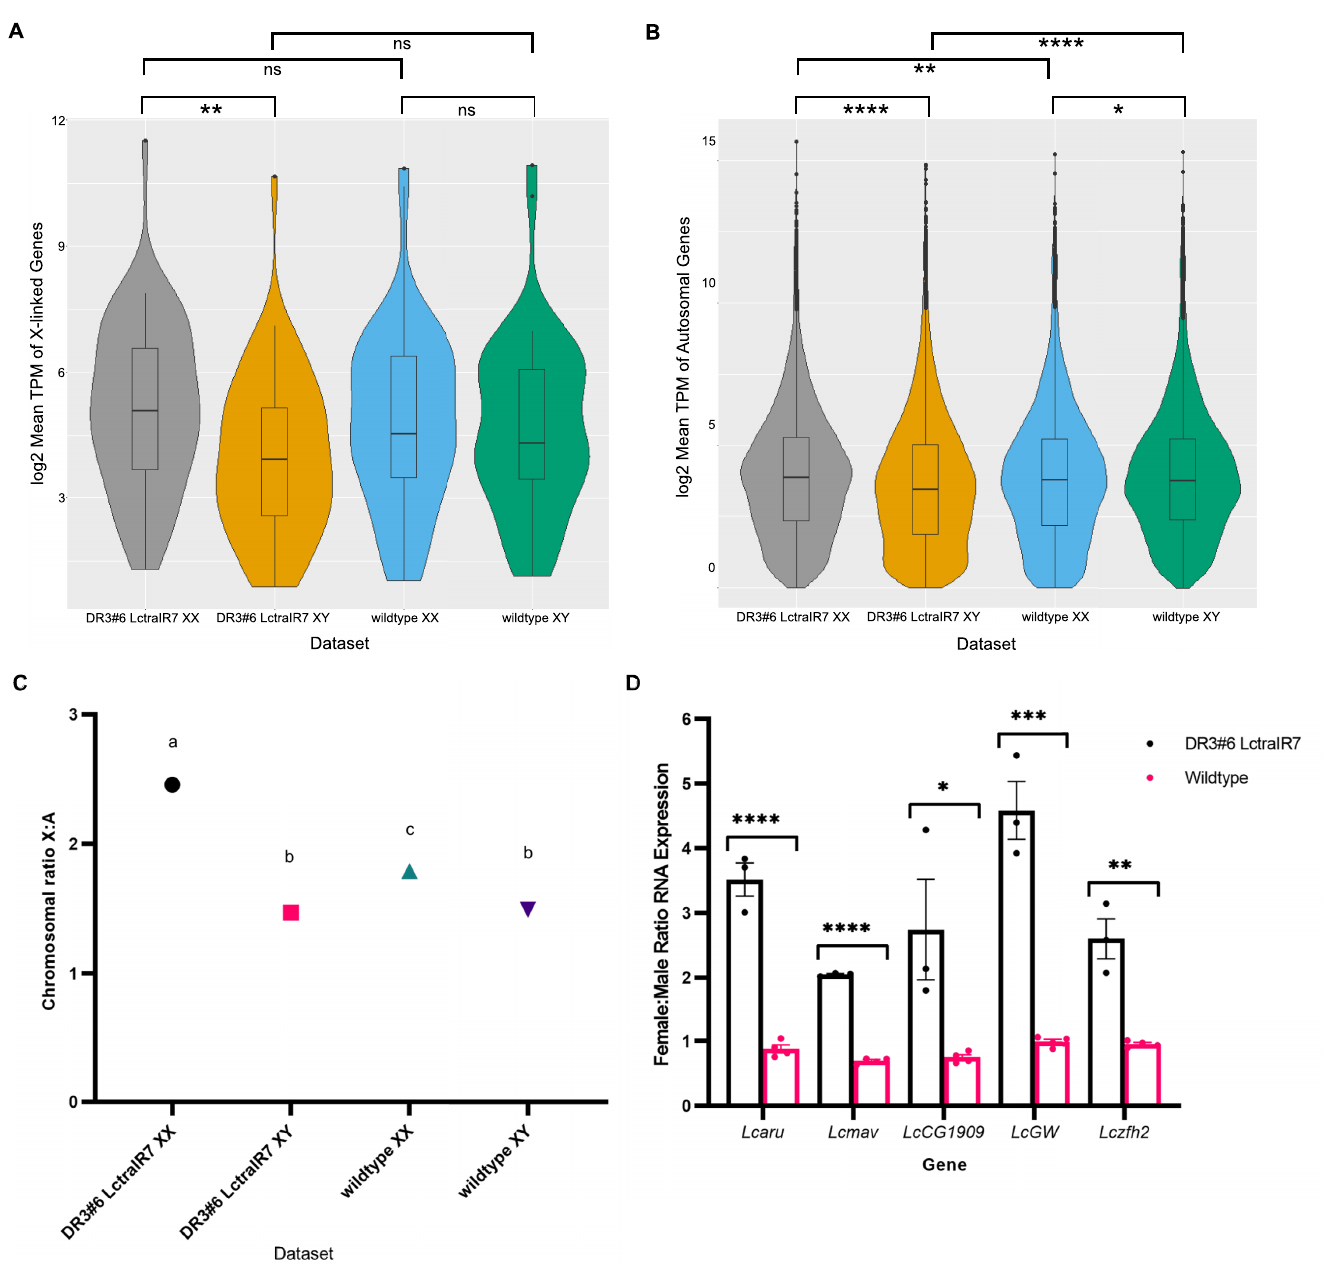
Fig 5. Knockdown of Lctra leads to increased X chromosome gene expression in XX flies. (A,B) Violin plots represent the normalized log 2 (TPM values + 1) of 54 X linked genes (A) or autosomal genes (B) that were above the threshold for significant expression for RNA mappings of each sex of DR3#6; LctraIR7 and wildtype to the reference. Boxplots within the violin plots represent the median and quartile ranges while the body of the violin plot shows the density of gene distribution. RNA was isolated from mid-stage pupae. The maternal and larval diets did not contain tetracycline. Significance is donated where � P < .05, �� P < 0.01, ��� P < 0.001, and ���� P < 0.0001 (Mann-Whitney U test). (C) Median X:A ratios for the average TPM values of each sample type. Median X:A ratios with different letters are significantly different (Tukey’s HSD, P < 0.05). (D) qRT-PCR analysis of RNA levels for five X-linked genes shown by the ratio of XX:XY RNA expression for each strain. Biological replicates are shown as circles and bar indicates mean ratios of transcript levels in XX pupae compared to XY pupae with standard error. Significance is donated where � P < .05, �� P < 0.01, ��� P < 0.001, and ���� P < 0.0001 (Student’s t-test).